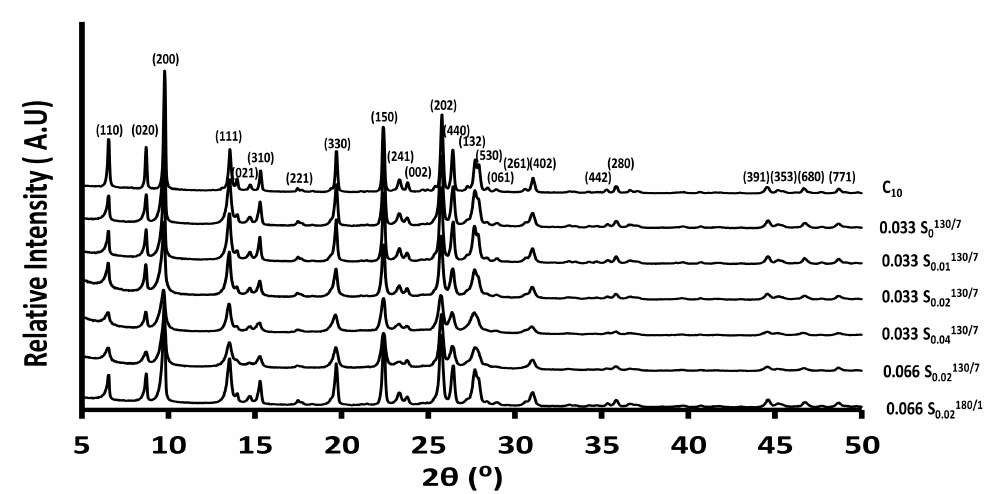
Figure 1. Wide-angle X-ray diffraction of the zeolites synthesized in the absence or presence (hierarchical zeolites) of